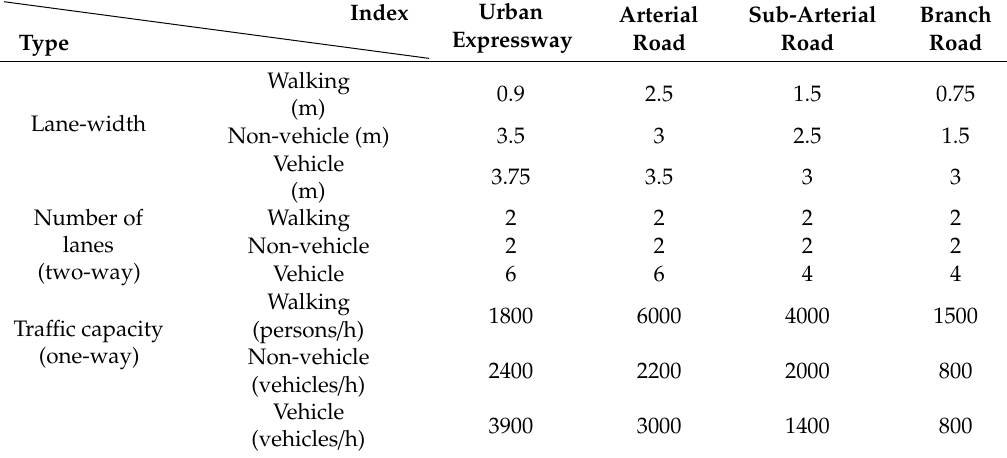
Figure 2. Layout of traffic network in Wenling, China. Table 1. Details of four road classes.